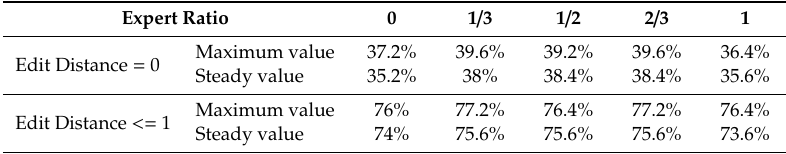
Figure 25. Full expert-driven learning. Table 4. Statistical results of the edit distance under the different expert ratios.